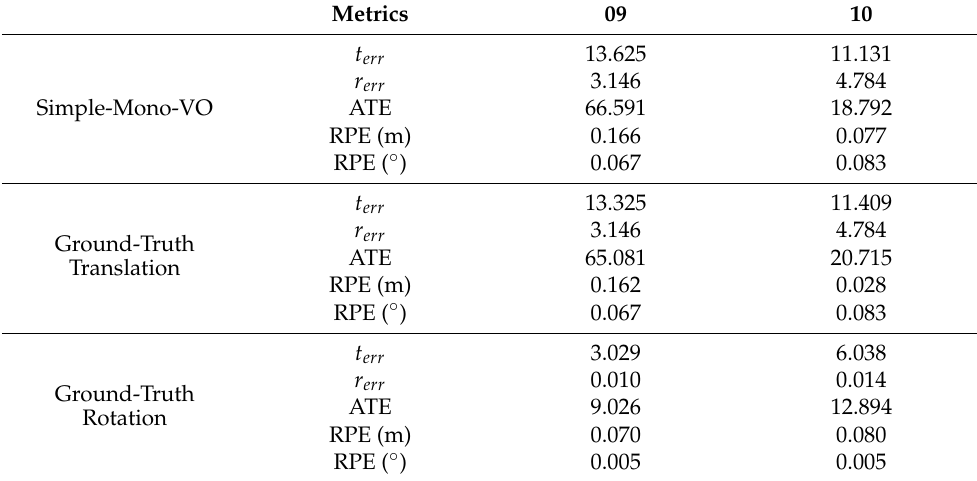
coming from unsupervised methods. Hence, we substitute alternately the ground-truth translations and rotations in the pose network estimates. We show the variation in the relevant metrics for the KITTI test sequences 9 and